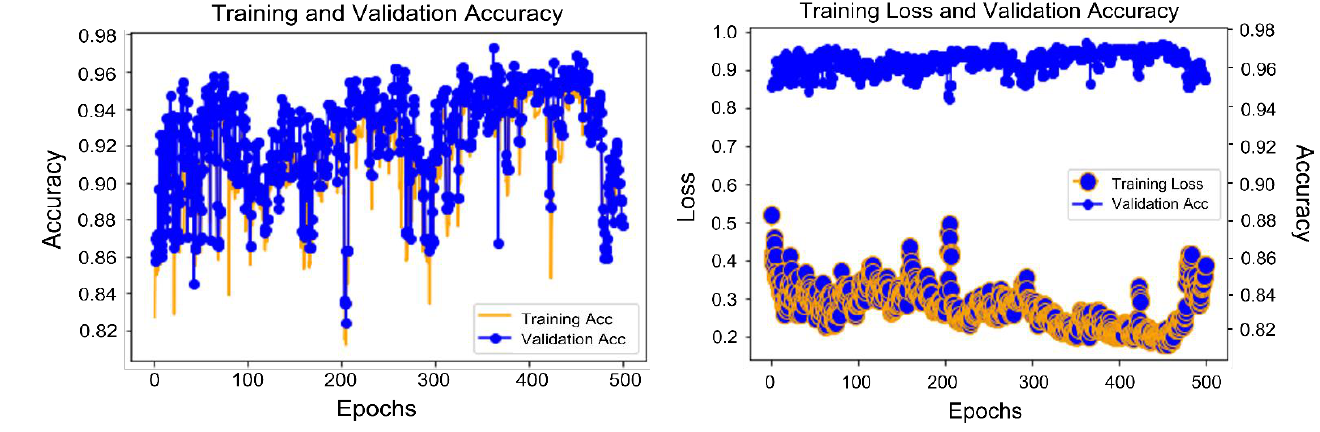
Figure 8. Validation accuracy vs. training loss and training accuracy results with 500 epochs.